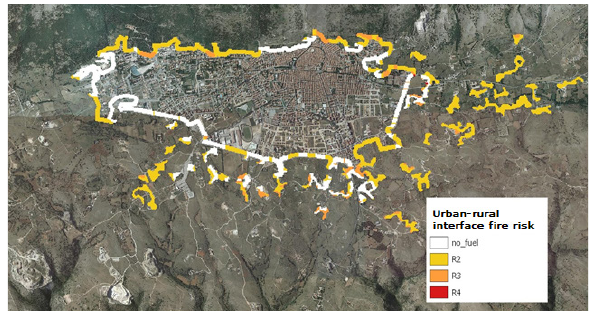
Figure 11 . Example of urban-rural interface fire risk calculation for a municipality of Apulia